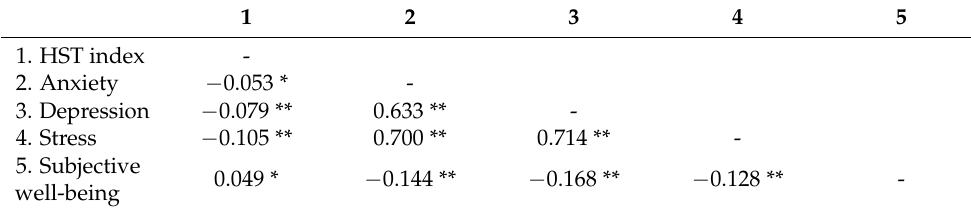
Table 4. Pearson’s correlation coefficients of HST index scores and the psychological